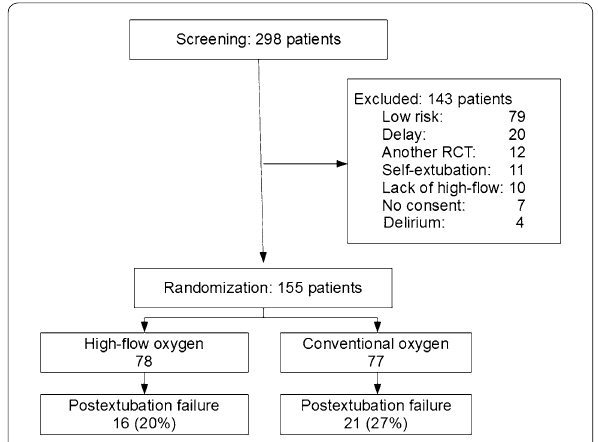
Fig. 1 CONSORT flowchart of the